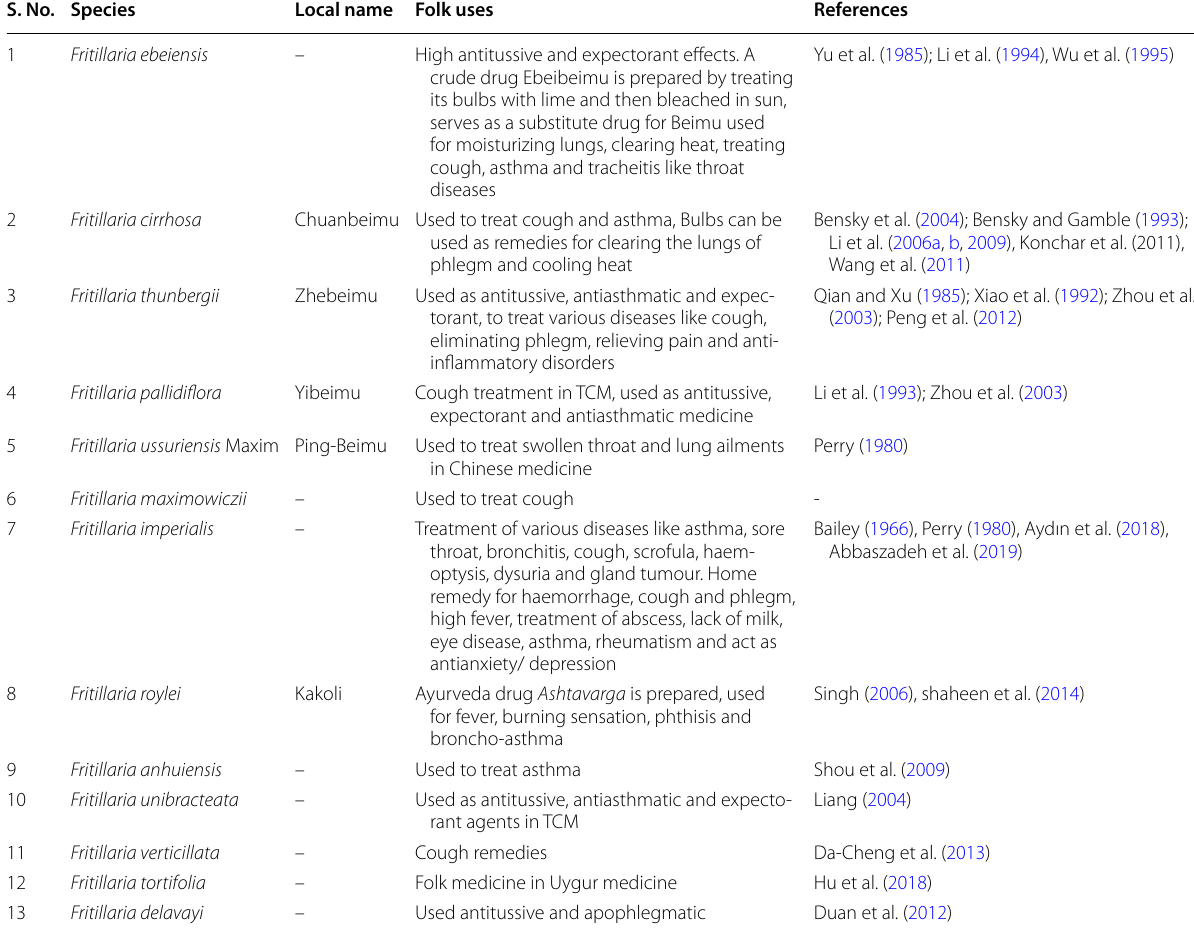
Table 1 Commonly used species of genus Fritillaria with their folk uses S. No. Species